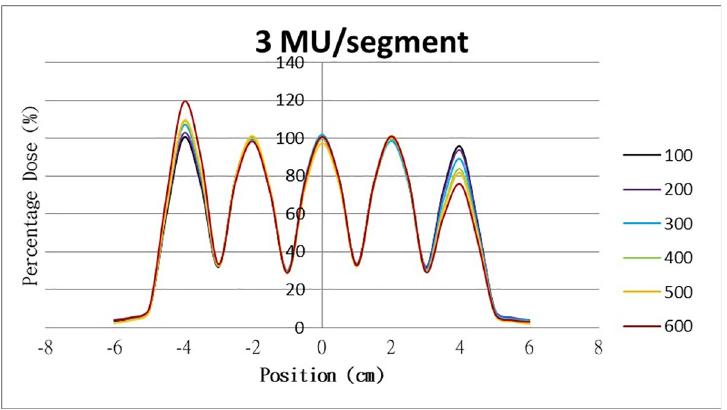
Fig 8. Overshoot effect measured at various MU values and dose rates. Overshoot effect, at various dose rates, for (6) 1 MU, (7) 2 MU, (8) 3 MU, (9) 4 MU, (10) 5 MU, (11) 6 MU, (12) 7 MU, (13) 8 MU, (14) 9 MU, (15) and 10 MU.